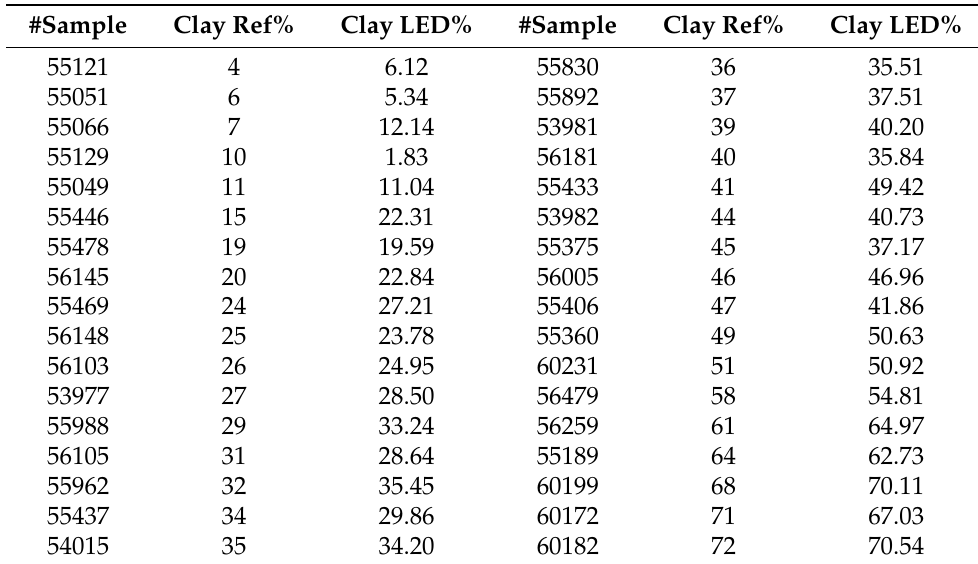
Figure 5. Results of machine learning calibration model. Table 6. Prediction results using Kennard–Stone